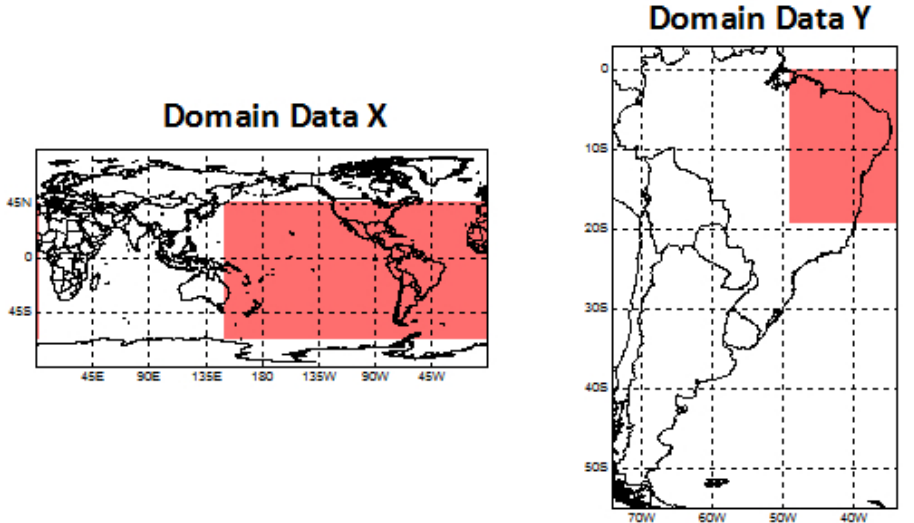
Figure 3. CCA areas for the predictor X ( left ) and the predictand Y ( right ) domains (adapted from Figure 1 by [15]).